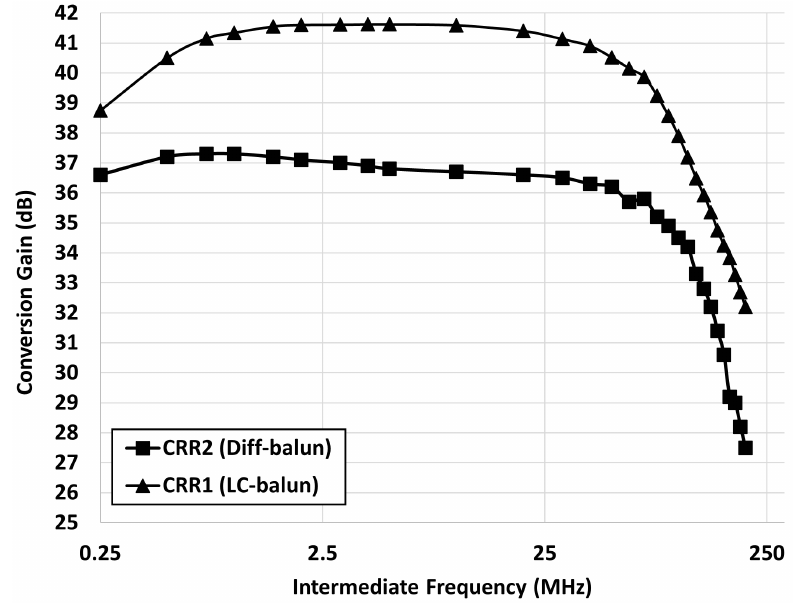
Figure 10. The conversion-gain performance of CRR1 and CRR2 versus the RF input.